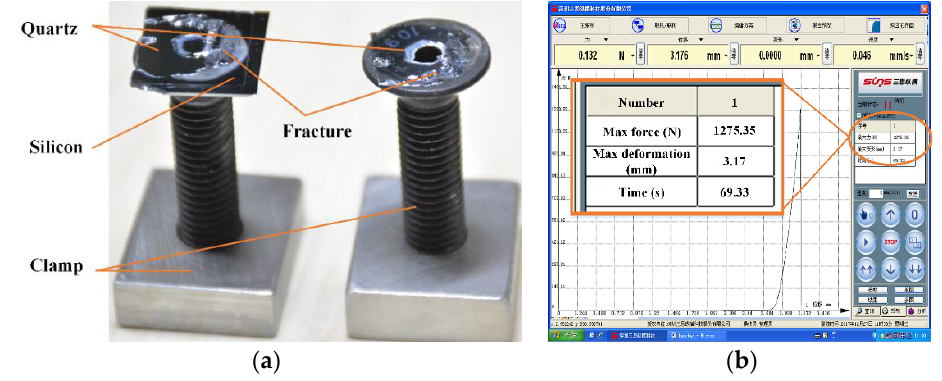
Figure 6. Tensile test of the silicon – quartz bonded wafer: ( a ) the fracture surface of the broken QoS wafer after stretching and ( b ) the tensile force of the bonded wafer.